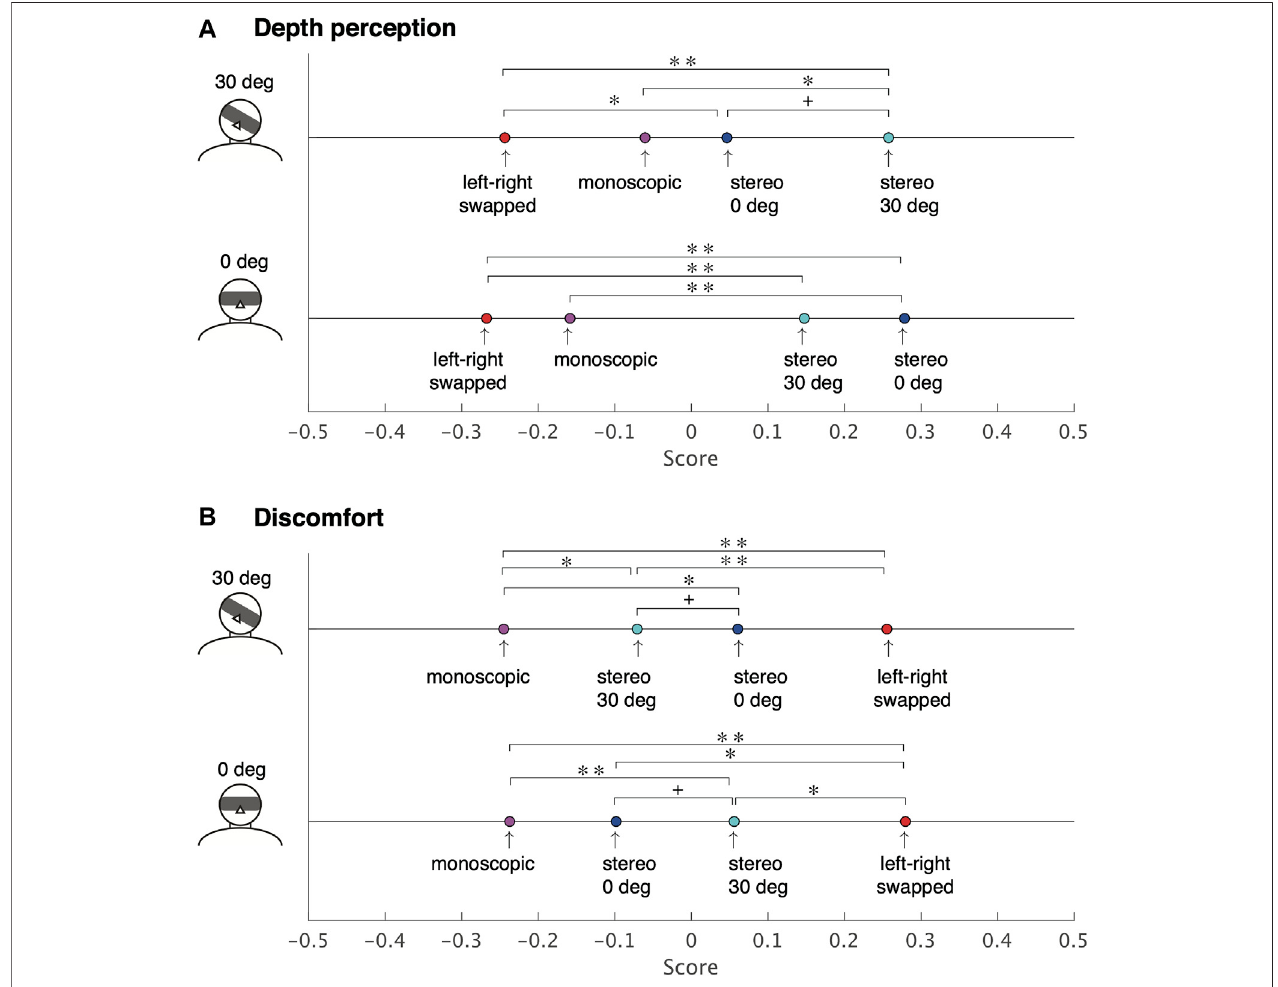
FIGURE 12 | Thurstone scale of the depth perception (A) and the visual discomfort (B) when the observers tilt their head in the roll direction (Experiment 1). (** p < 0.01, * p < 0.05, + p < 0.10).